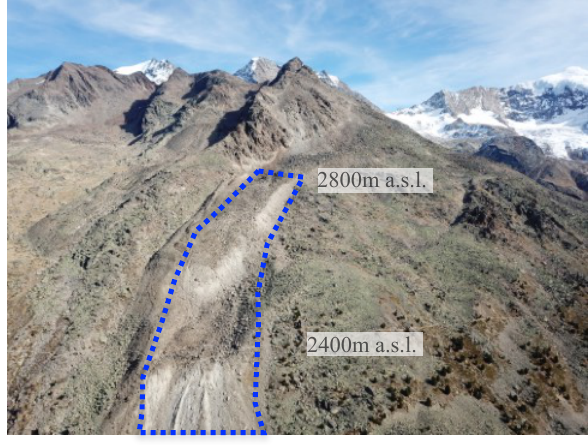
Figure 1. Location of test site at Jegihorn, Valais, Switzerland.